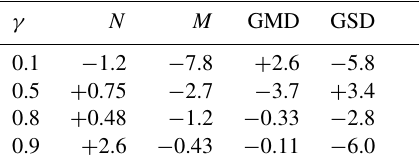
Table 4. Relative errors (%) of the variables in the chamber sim- ulation with the PL + LN model using different values for the con- densational transfer factor γ . The errors are compared to the FS400 model, except for M that is compared to the MC100